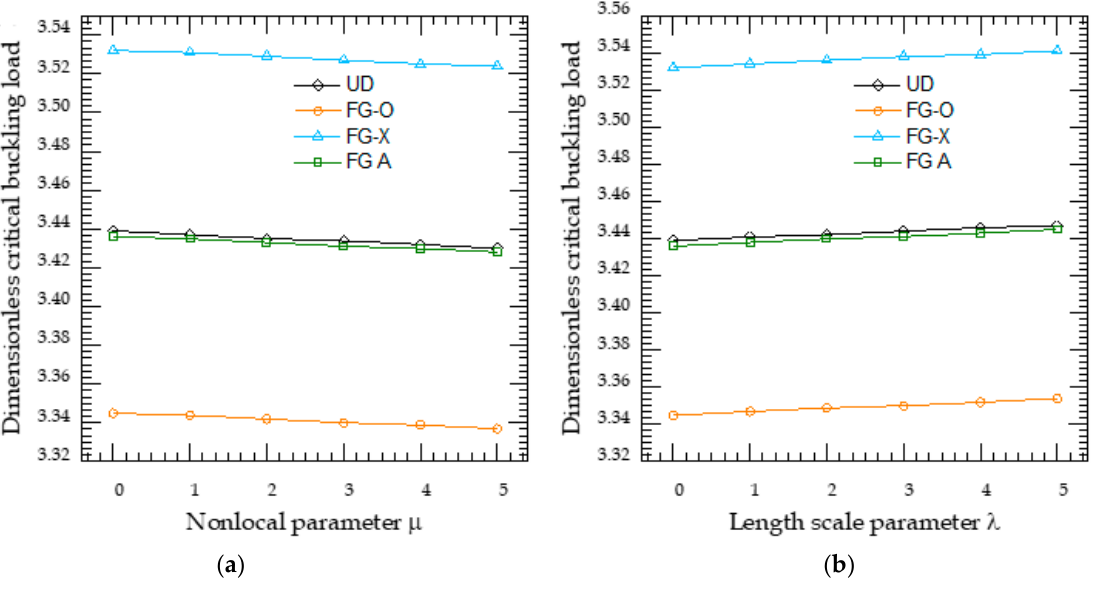
Figure 3. Dimensionless critical buckling load of simply supported GRNC plate under effect of: ( a ) Nonlocal parameter ( b ) Length-scale parameter, for various GPLs reinforcement patterns (g (cid:2891)(cid:2900)(cid:2896)∗ = 1%) .